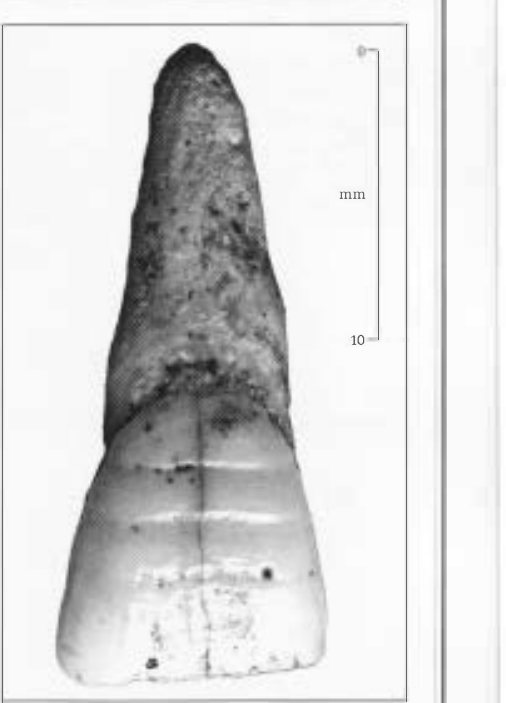
Figure 2 Hypoplastic defects on the sur­ face of an anterior tooth (upper left incisor) from one of the specimens selected for analysis. The hypoplastic defects repre­ sent disruptions to regular crown growth and are visible as furrows running horizon­ tally across the